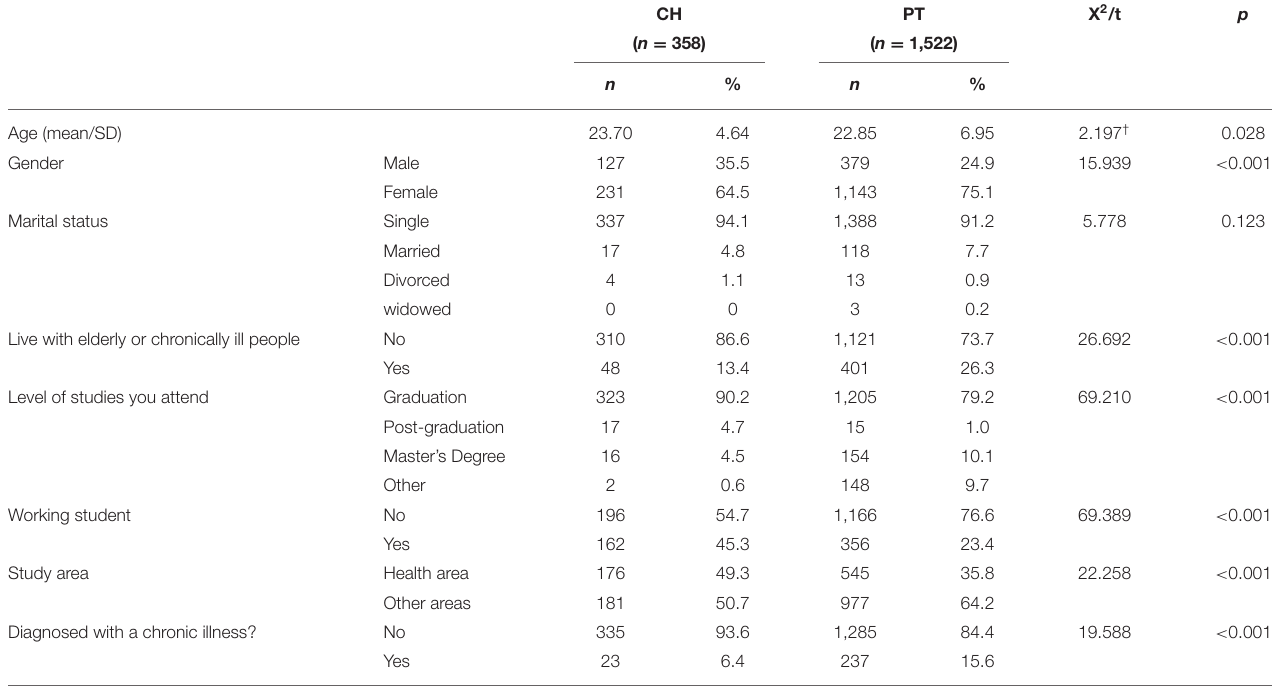
TABLE 1 | Association between the sociodemographic/health variables and participants country of origin ( n = 1,880).